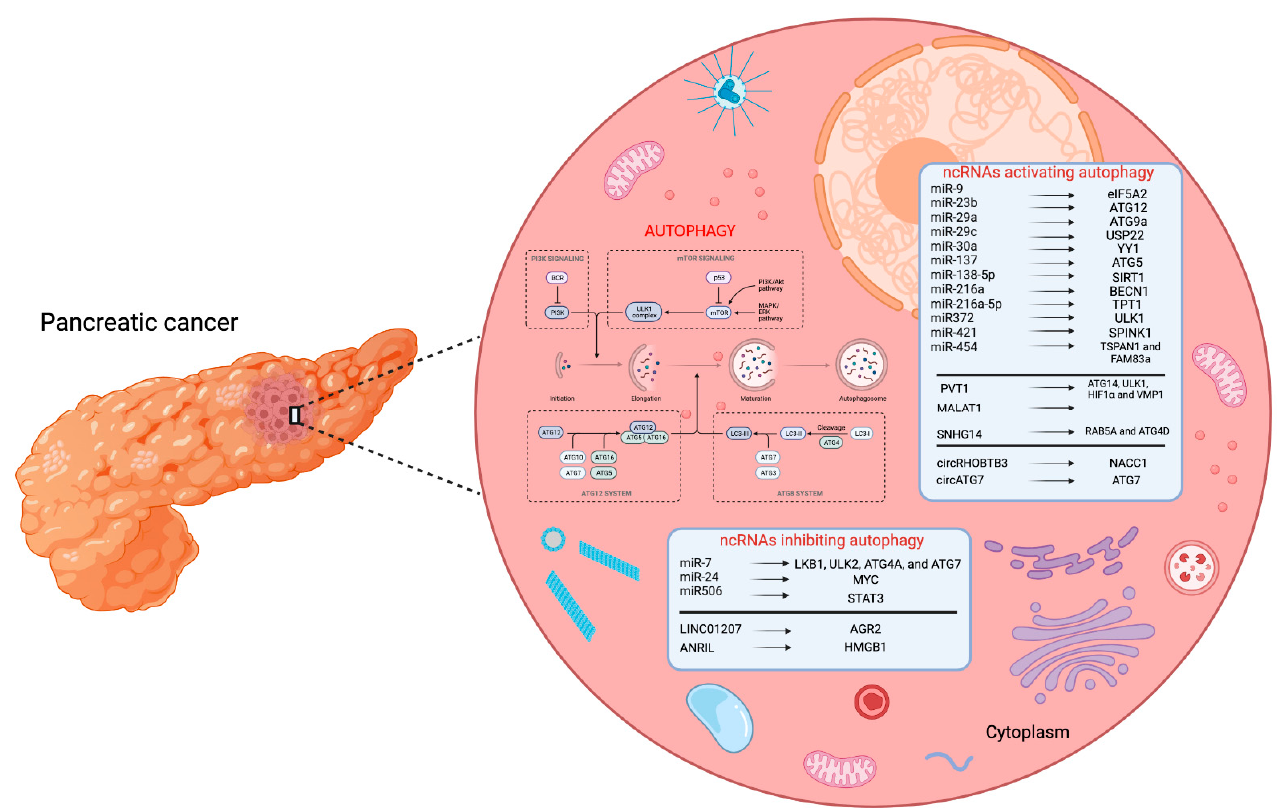
Figure 1. Overview of the autophagy-related ncRNAs that have been suggested as potential biomarkers in PC.